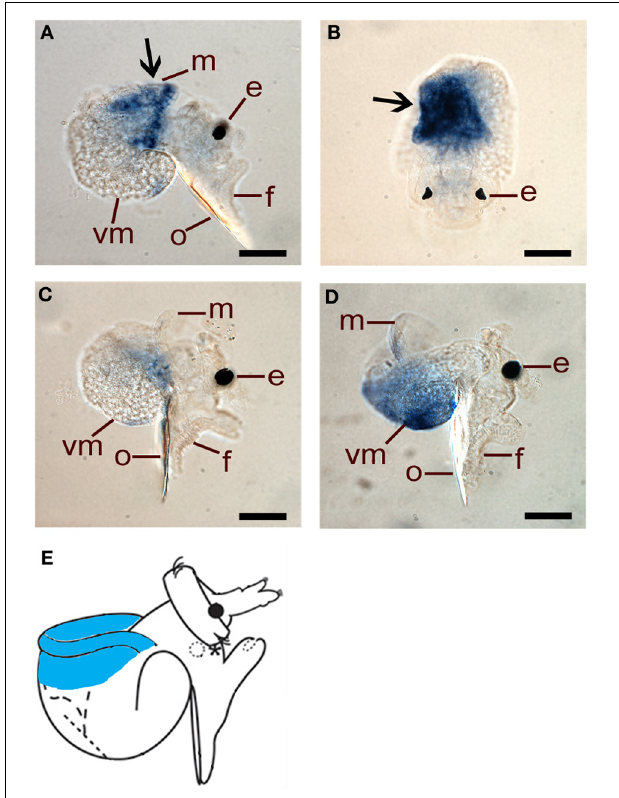
FIGURE 7 | Spatial expression of HasHSP90A assessed by whole mount in situ hybridisation. (A,B) Right lateral and dorsal views of 48hpf pre-competent larvae. Probe concentration of 1ng/ μ l was used. Arrows indicate HasHSP90A localisation in mantle tissue. (C) Right lateral view of 72hpf pre-competent larvae. Probe concentration of 1ng/ μ l was used. (D) Right lateral view of 96hpf competent larvae. Probe concentration of 1ng/ μ l was used. In (C,D) HasHSP90A localisation becomes hardly detectable. (E) A schematic representation of HasHSP90A localization. The localization in mantle tissue is indicated by blue. e, eyespot; f, foot; m, mantle; o, operculum; vm, visceral mass. Scale bars: (A–D) , 50 μ